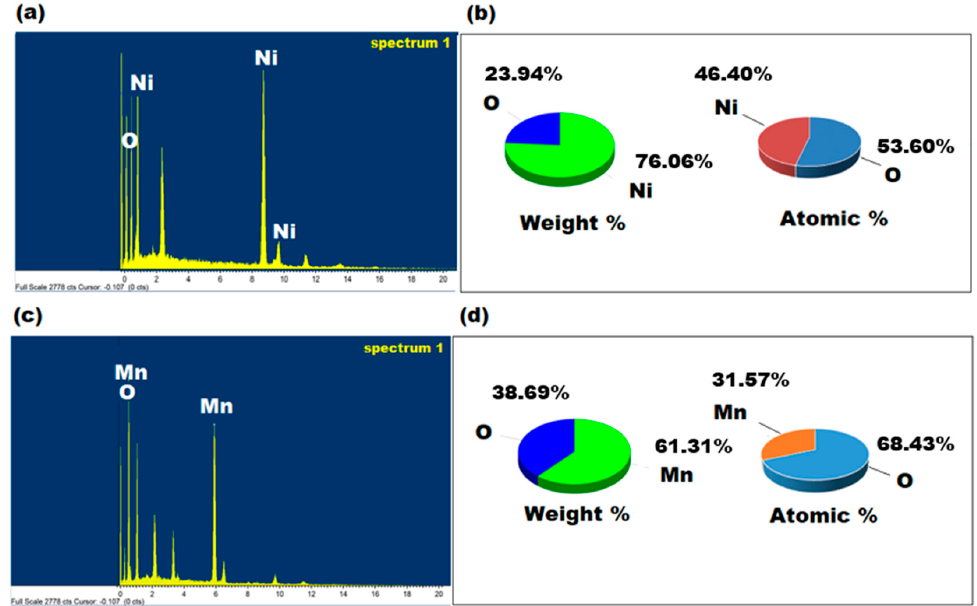
Figure 5. ( a , c ) EDX spectra of the green synthesized NiONPs and MnO 2 NPs using Mentha spicata and Malus domestica peel extracts, ( b , d ) represent the weight percentage and atomic percentage of the synthesized nanoparticles,